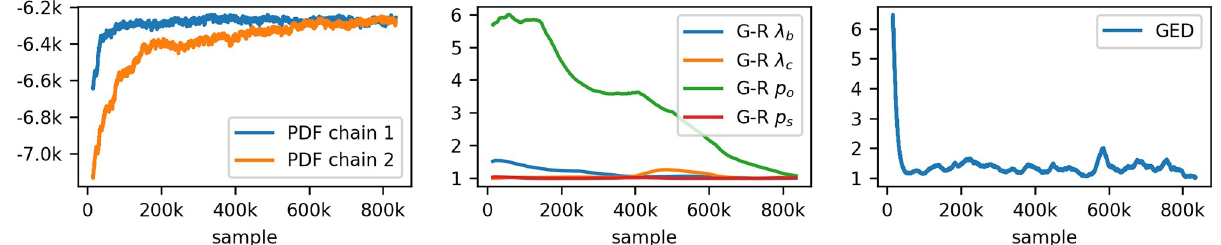
Fig 3. Convergence. The panels show: the posterior density of the two chains; the Gelman-Rubin statistics for the four tracking control parameters and the GED criteria, (average-cross-chain-GED)/(sum-of-average-inner-chain-GEDs).